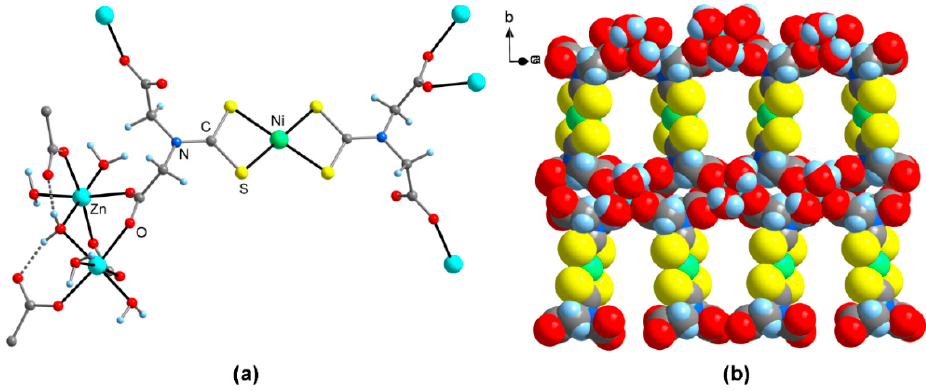
Figure 3. Molecular structure of Zn 2 [Ni(H 2 L) 2 ] ( 5-Ni ) · 2.5acetone · 8.5H 2 O in the crystal (non-coordinated solvent of crystallization omitted for clarity). ( a ) Balls-and-sticks model of one formula unit; ( b ) Representation of the two-dimensional polymeric structure (space-filling model). Table 2. Selected interatomic distances (pm) and angles (deg.) in heterobimetallic coordination polymers of the type Zn 2 [M(L) 2 ] (M = Ni, Pd, Pt). Compound